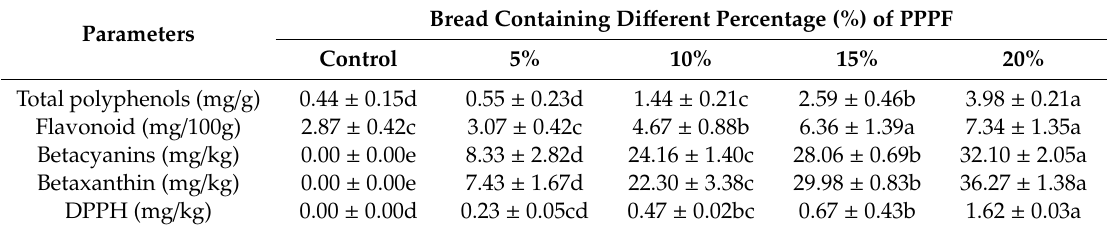
Table 7. Bioactive compound of bread containing di ff erent amounts of